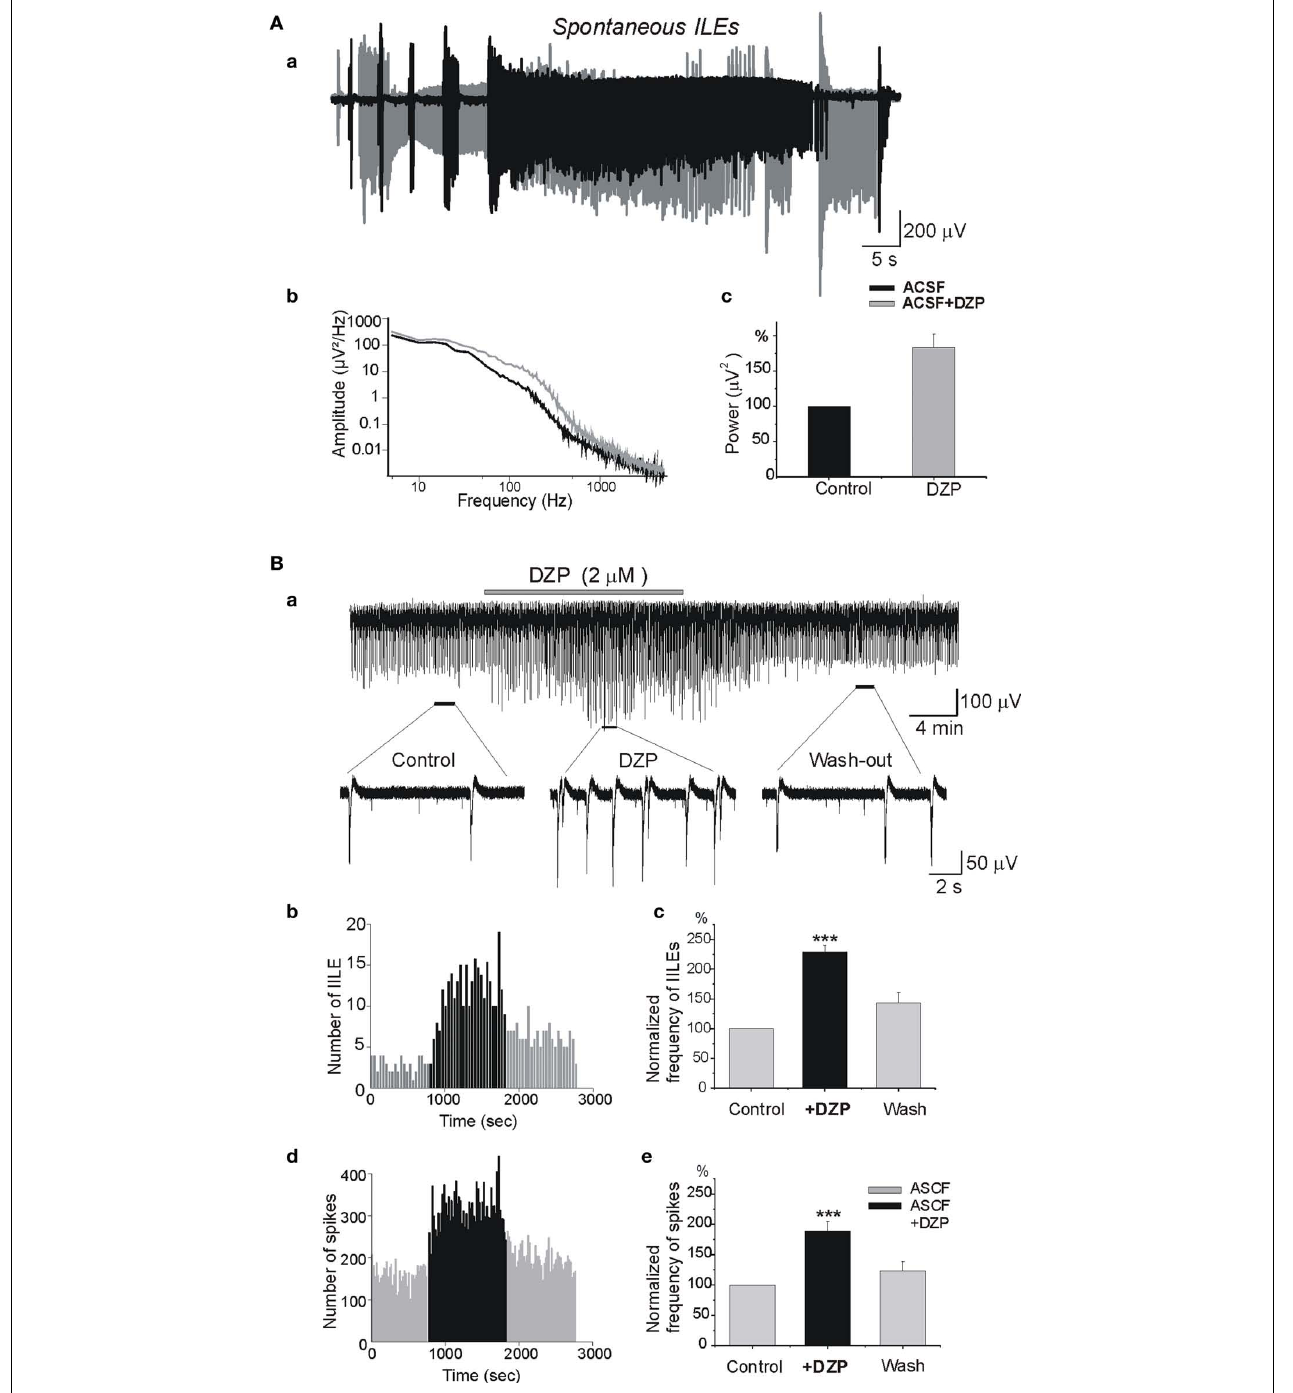
after the formation of a MF. Slices generated spontaneous IILEs and multi-unit activities (MUAs) continuously that were reversibly aggravated by DZP (2 μ M). (Bb) Quantification of IILEs from a single experiment [from (Ba) ]. (Bc) Average quantification histogram of IILEs. (Bd) Quantification of spikes from single experiment [from (Ba) ] and (Be) the average quantification histogram. Note that DZP increased the frequency of IILEs (by 128.7 ± 12.2%, n = 6, p < 0.001) and spikes (by 88.6 ± 16.2%, n = 6, p <